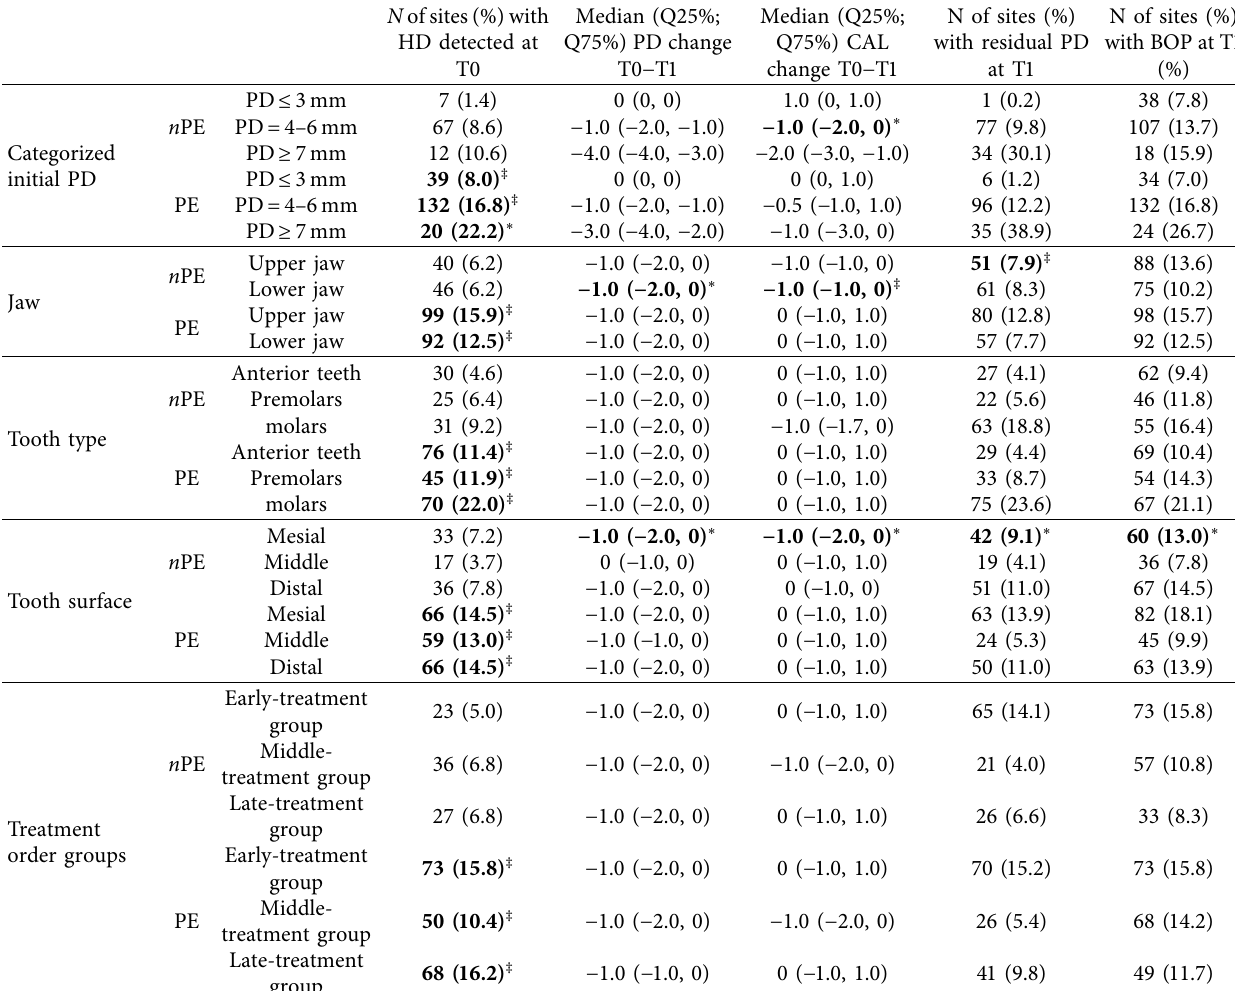
Table 3: Treatment results and part II subgroup analysis at the tooth surface